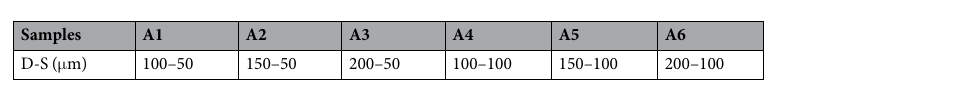
Table 1. Six samples with different hole diameters and